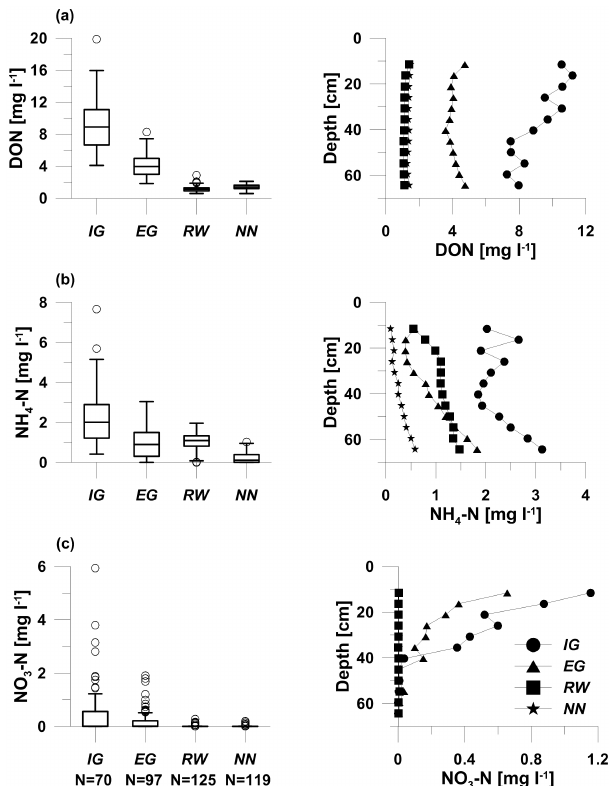
Fig. 8. Left: concentrations of (a) DON, (b) NH 4 –N and (c) NO 3 –N at the study sites in the bulk samples (central crossbars represent the median, the boxes the 75th and 25th percentile and the circles ex- treme values). Right: vertical profiles of mean concentrations. Sam- pling date after cattle slurry application excluded (April